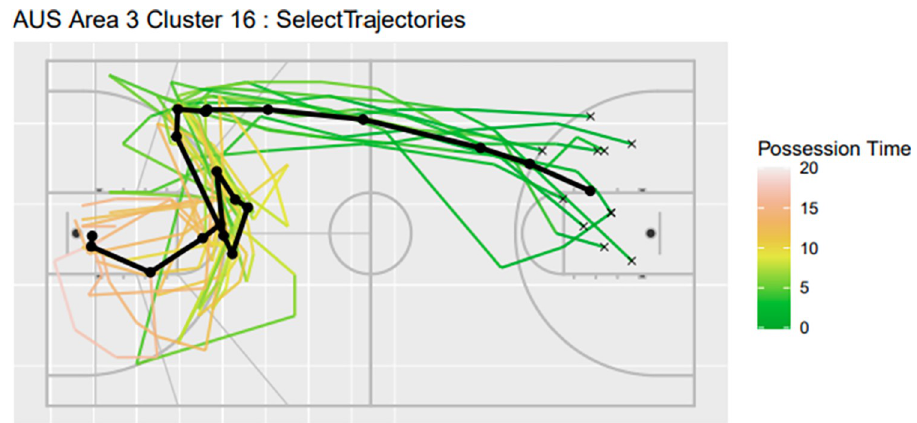
Fig 5. Temporal Trajectorial plots for Australia Area 3 Cluster 16.